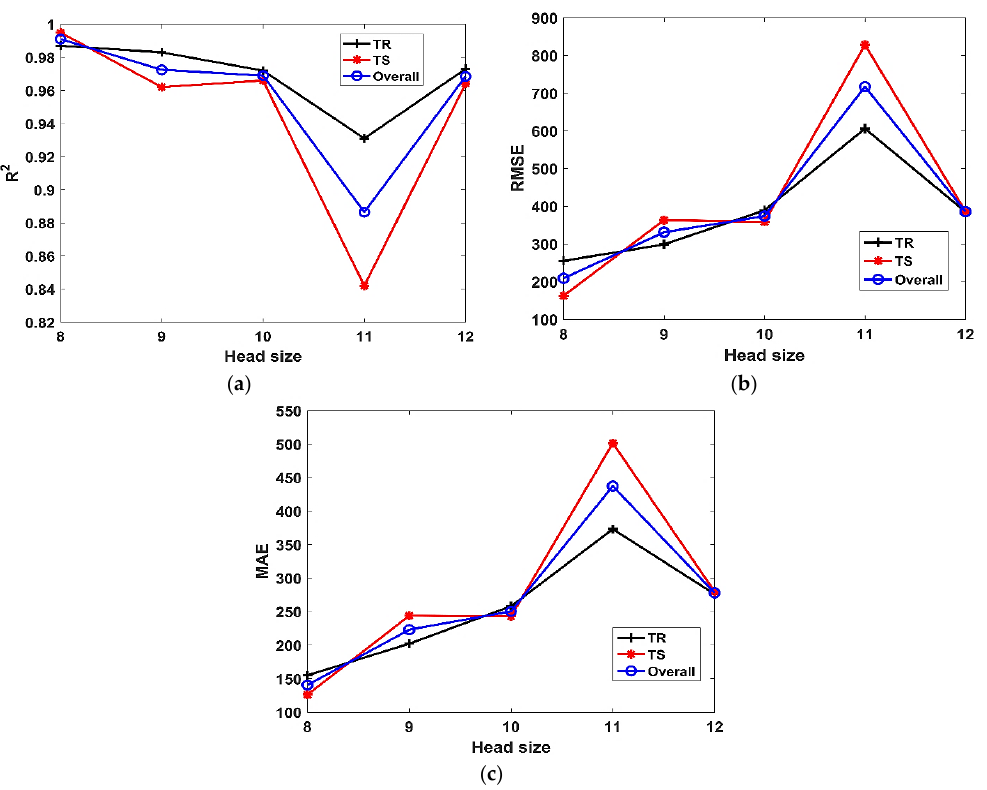
Figure 4. Effect of H s on the performance of models. ( a ) R 2 , ( b ) RMSE , ( c ) MAE .